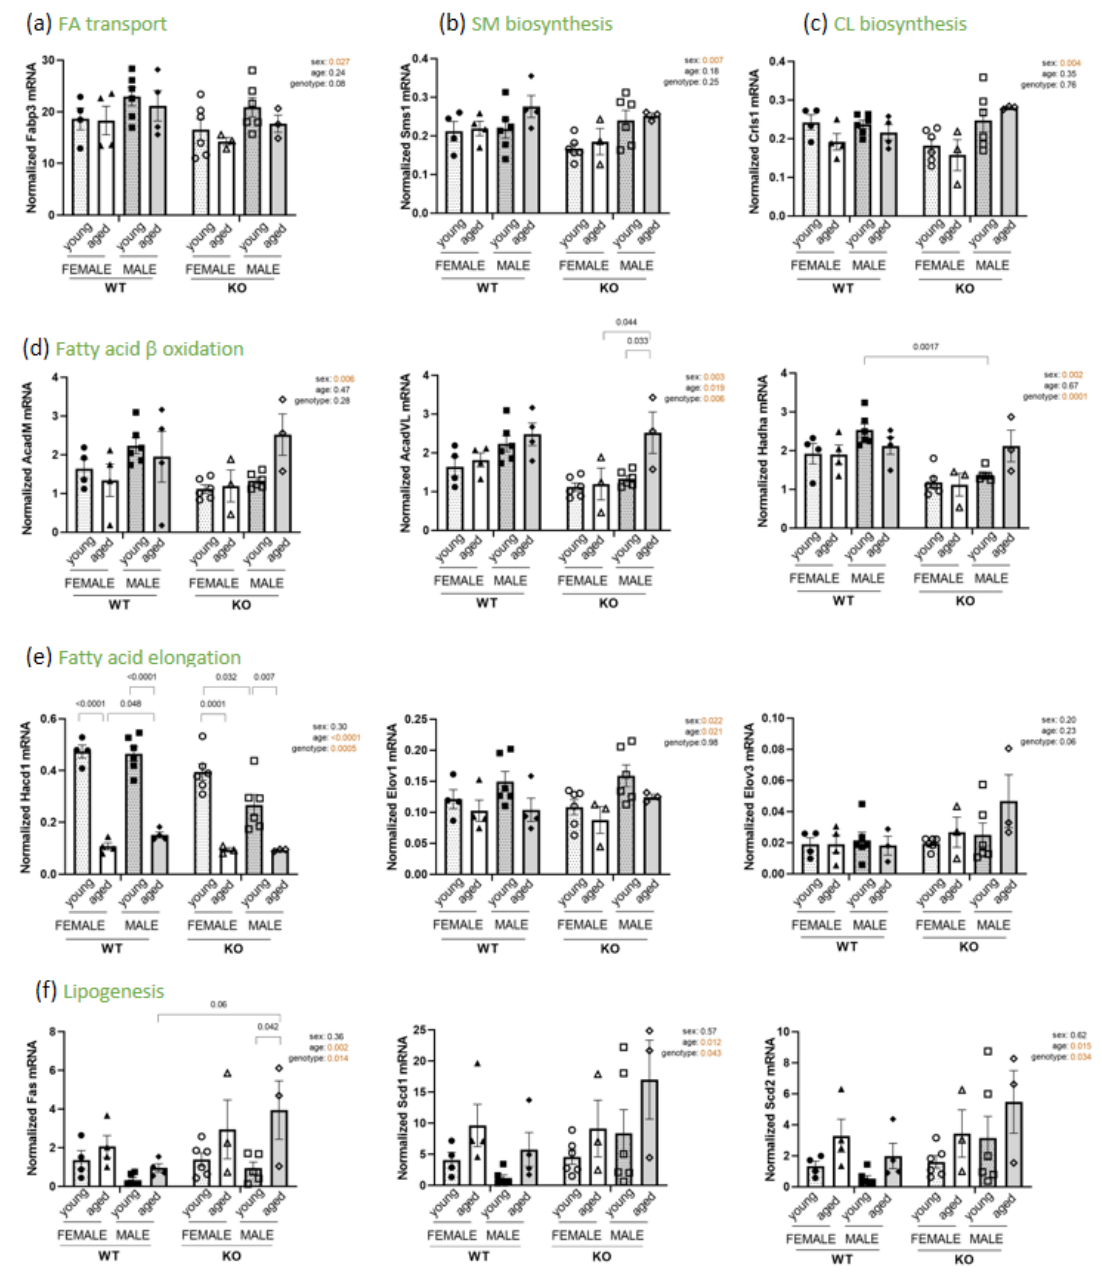
Figure 7. Lipid biosynthesis, remodeling and transport pathways. mRNA expression analysis in male and female, young and aged and WT and SelenoN KO diaphragm normalized to RPL19 and HPRT mean. ( a ) Fabp3 (fatty acid binding protein3) involved in FA transport. ( b ) Sms1 (sphingomyelin synthase 1) involved in SM biosynthesis. ( c ) Crls1 (cardiolipin synthase1) involved in CL biosynthesis. ( d ) AcadM (acyl-coA dehydrogenase medium chain), AcadVL (acyl-coA dehydrogenase very